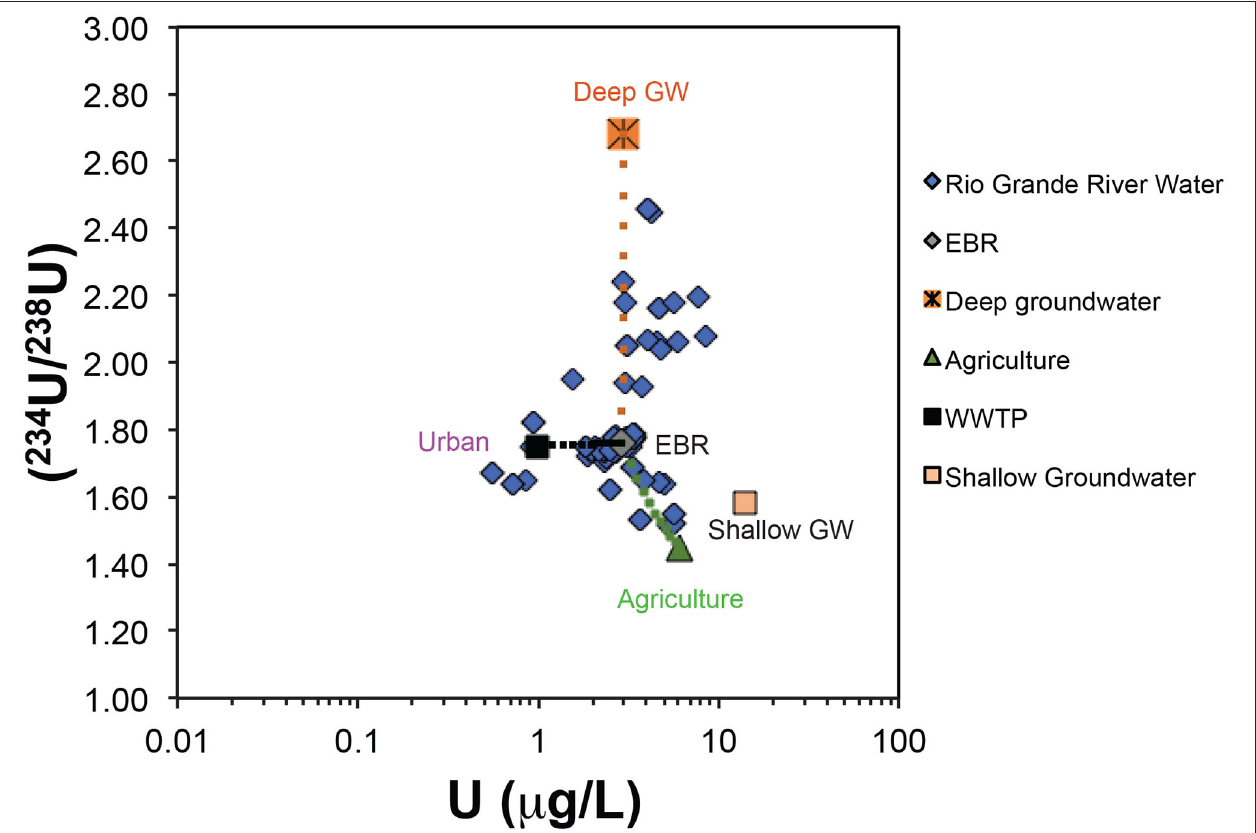
FIGURE 8 | U activity ratios vs. U concentrations in the Rio Grande river during non-irrigation seasons. End member values ( Table 1 ) for Elephant Butte Reservoir, shallow groundwater, deep groundwater, agricultural water, and urban water are indicated. Dashed lines indicate the conceptual model of multiple salinity contribution to the Rio Grande